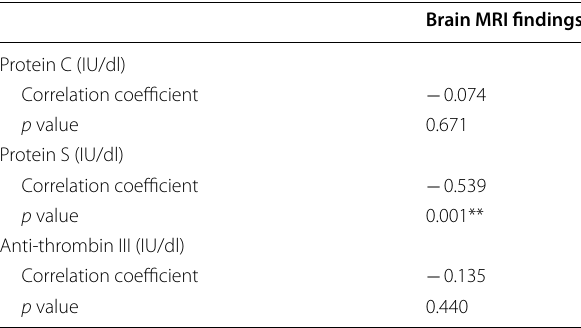
*Statistically significant at p 0.05 ≤ Table 6 Correlation of serum levels of protein C, protein S, and anti-thrombin III with brain MRI findings